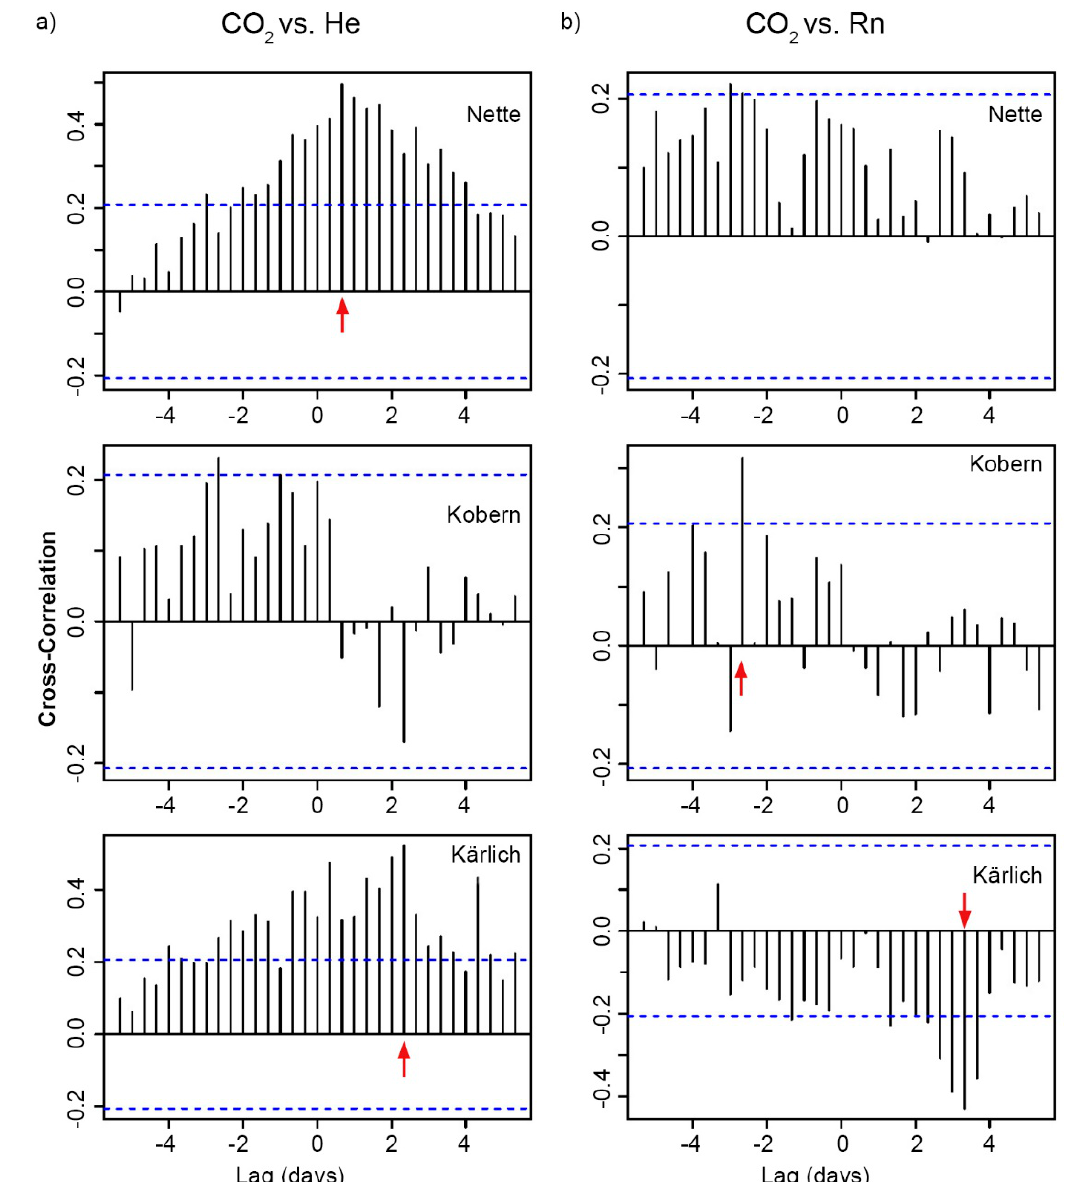
Figure 7. Cross-correlation of the time-series of ( a ) CO 2 vs. He, and ( b ) CO 2 vs. Rn (8-hourly samples; median smoothed) in all springs for the 4-W campaign. Red arrows indicate highlighted correlations. Blue dashed lines indicate 5% significance levels (values outside the blue dashed lines are statistically significant at P ≤ α = 0.05).